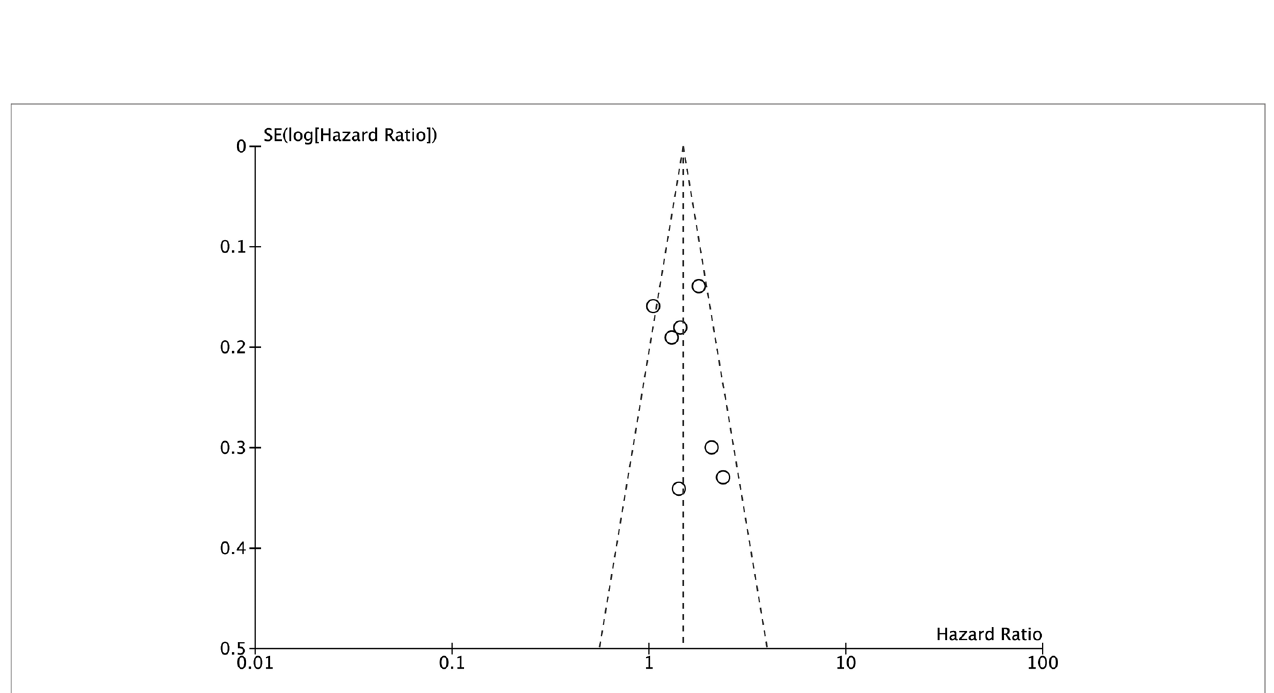
FIGURE 4 | Funnel plots of disease free